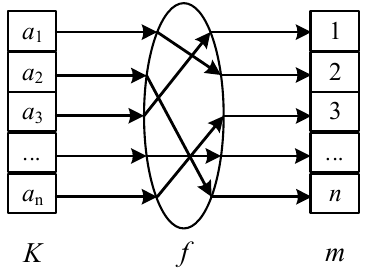
Figure 3. Hash table data structure.